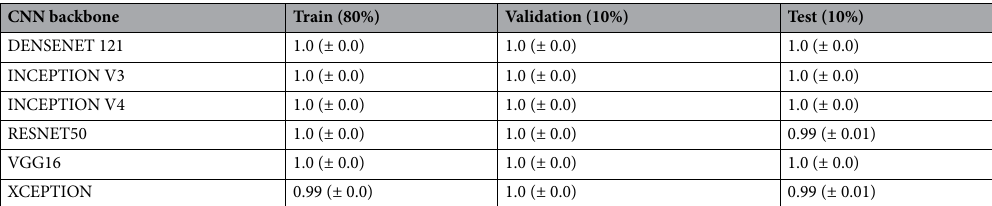
Table 1. Classification accuracy of CNN backbones. 95% confidence intervals between parenthesis. Number of training epochs is shown between parentheses of the CNN backbone column.